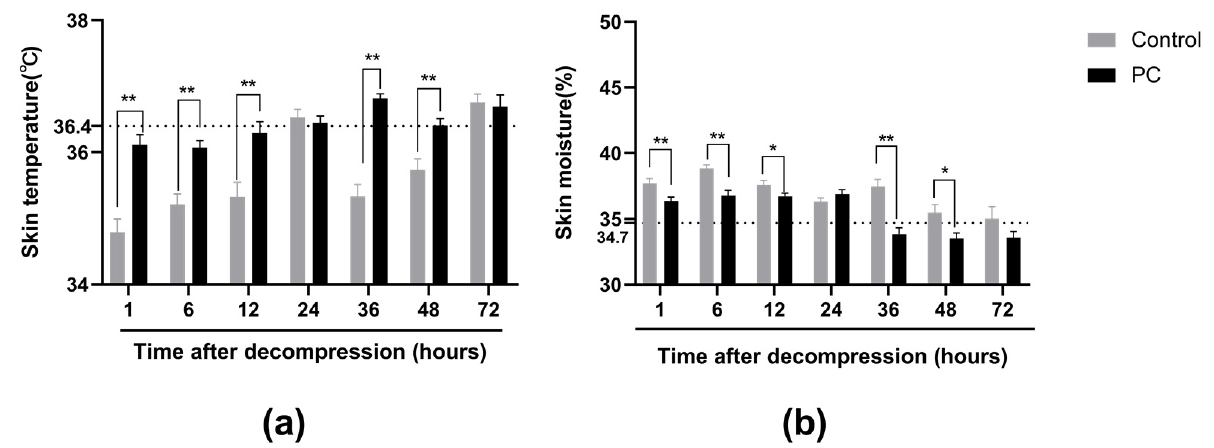
Figure 3. Skin temperature ( a ) and moisture ( b ) of PI wounds after decompression in two groups. Rat normal skin temperature was 36.4 ± 0.5 °C, and normal skin moisture was 34.7 ± 1.8%. * p < 0.05, ** p < 0.01. PC: preconditioning. The dotted line represents the normal value.